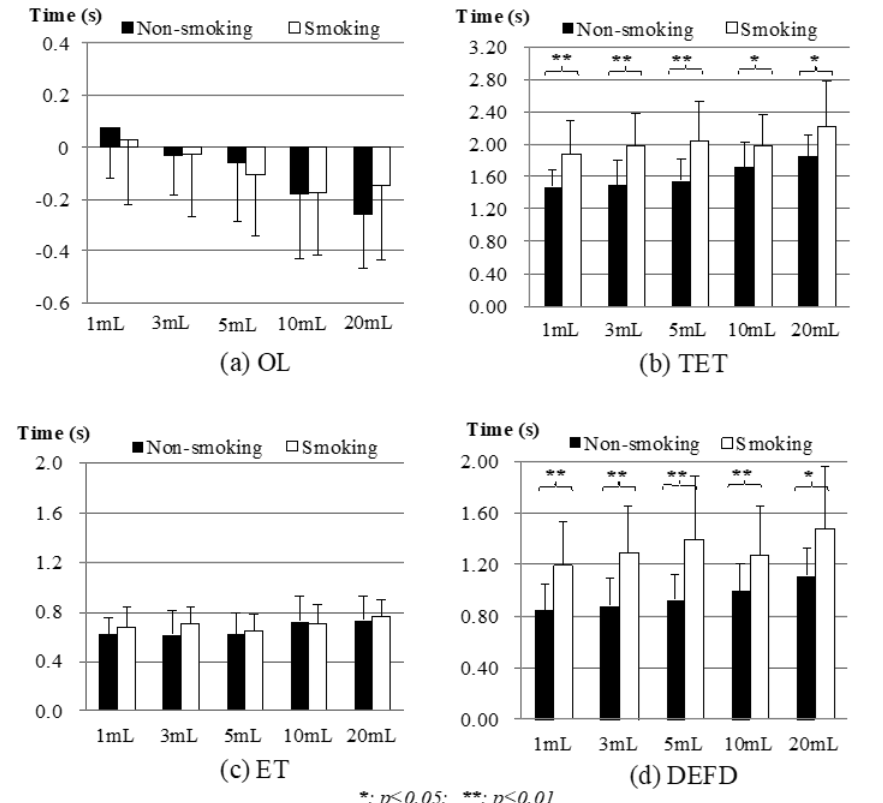
Figure 9. Comparison of FSR signals between nonsmoking and smoking groups: ( a ) Onset Latency (OL); ( b ) Total Excursion Time (TET); ( c ) Excursion Time (ET); ( d ) Duration of Second Deflection (DEFD). Piecemeal swallowing cases were excluded.